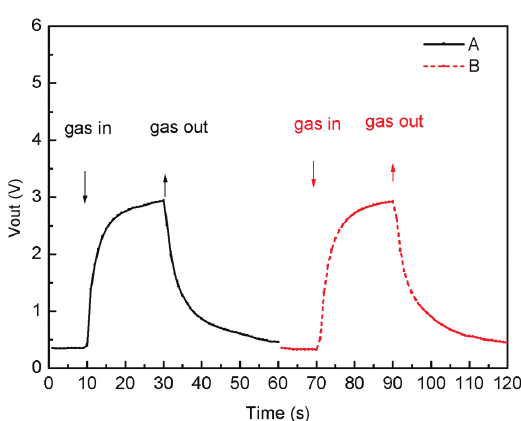
Figure 8. Curve C—7 at% Sn-doped ZnO under the visible light irradiation, Curve D—7 at% Sn-doped ZnO in